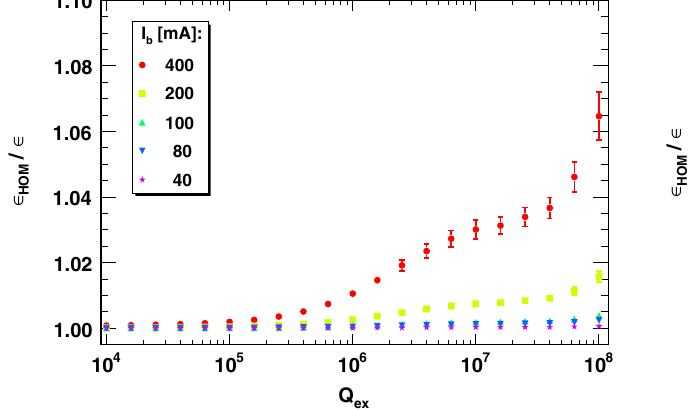
FIG. 29. Average effective transverse phase space growth of the beam as a function of the Gaussian bunch to bunch charge i where b scatter. Settings: N ¼ 100 , see Table IX. i 2 . The b